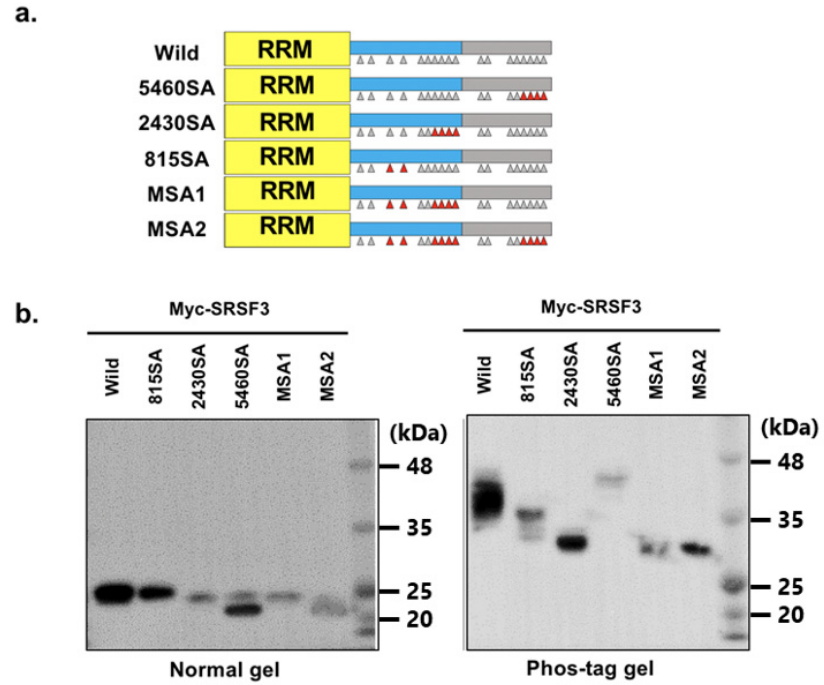
Figure 3. Analysis of phosphorylation status of SRSF3 with multiple serine to alanine replaced mutants. ( a ) Structure of SRSF3 multiple serine to alanine replaced mutants. Replaced serine are shown as a red triangle. ( b ) Expression of transfected Myc-SRSF3 and multiple serine to alanine replaced mutants was detected by western blotting with an anti-Myc antibody (left panel, separation with SDS-PAGE; right panel, separation with phos-tag SDS-PAGE).